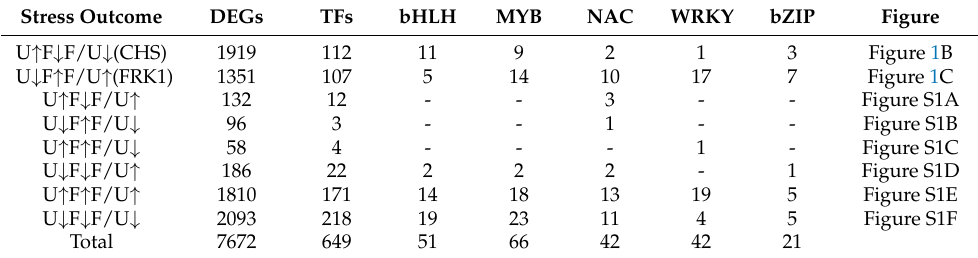
Table 1. Overview of some transcription factor families identified under the eight possible stress treatment outcomes.